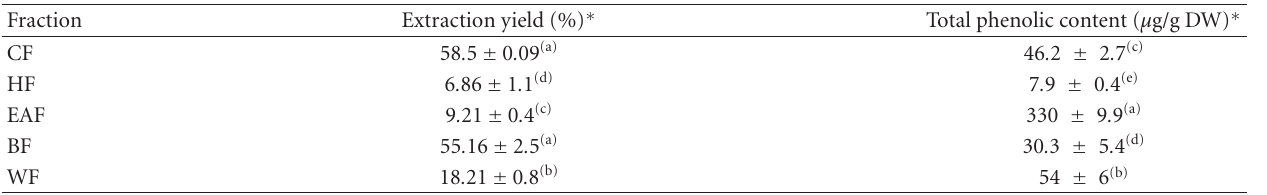
Table 1: Comparative analysis of extraction yield and total phenolic content of wampee peel fractions obtained using di ff erent solvents. Fraction